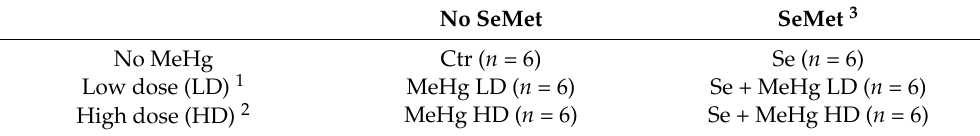
Table 1. Experimental design and dosages of MeHg and